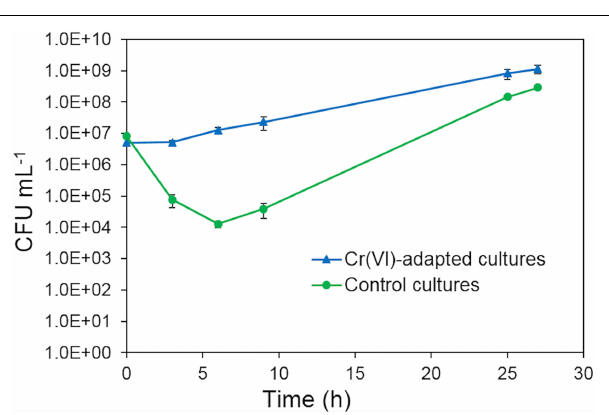
FIGURE 3 | Growth of Klebsiella sp. strain AqSCr in LB medium (pH 8) with 11 mM Cr(VI), starting with cells with pre-exposure (blue triangles) and without pre-exposure (green